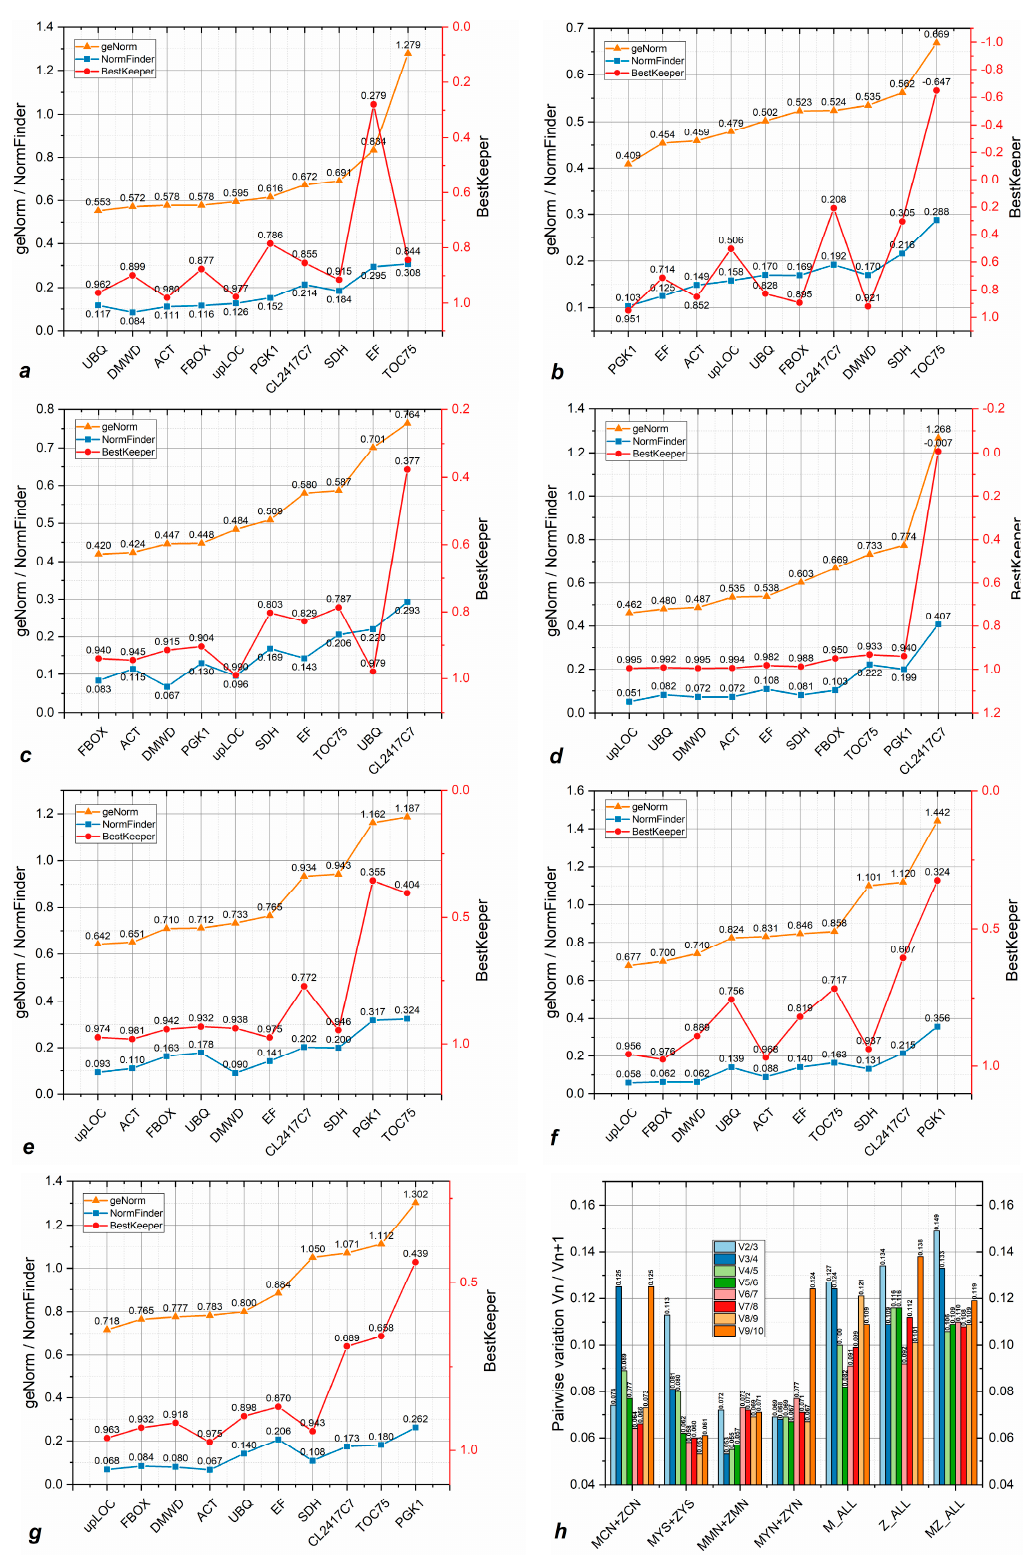
Figure 5. Stability values per gene as calculated using three separate algorithms (geNorm, NormFinder, and BestKeeper). Figures display the stability value data per gene of: ( a ) MCN+ZCN; ( b ) MYS+ZYS; ( c ) MMN+ZMN; ( d ) MYN+ZYN; ( e ) all P. massoniana samples; ( f ) all Z pine samples; ( g ) all P. massoniana and Z pine samples; and ( h ) pairwise variation calculated by geNorm. Table 3. The recommended and NOT recommended reference genes for each tissue type/species.